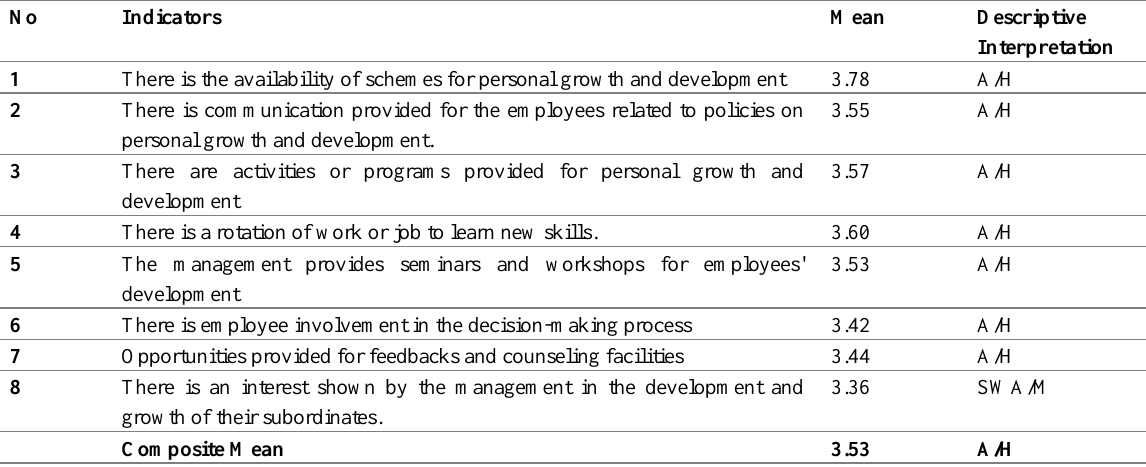
Table 6: Personal growth and career